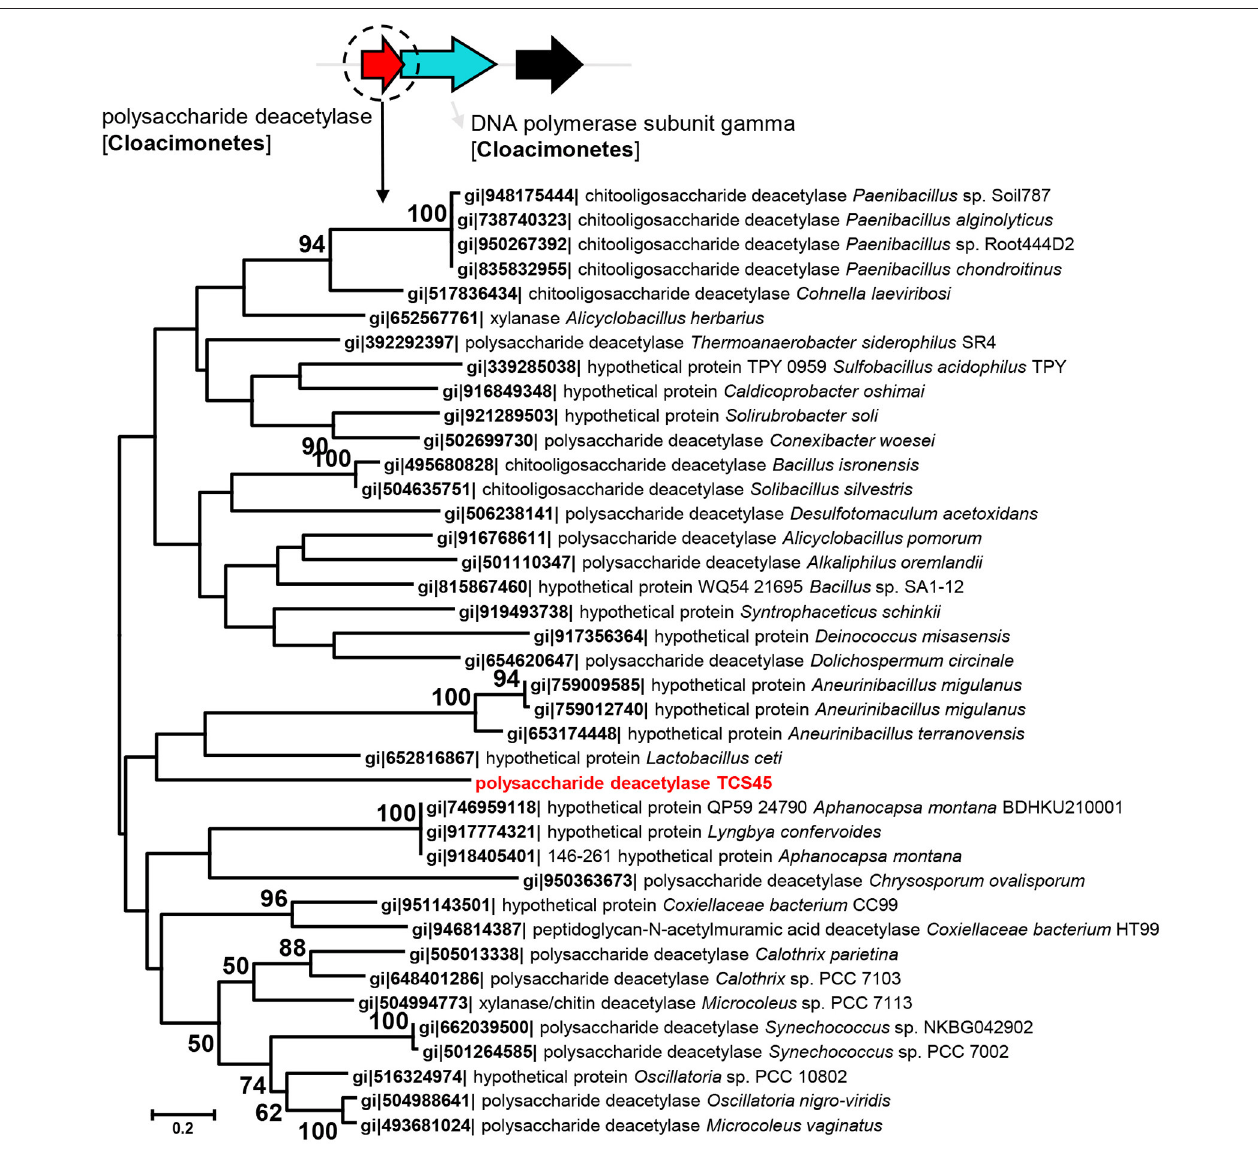
FIGURE 2 | Maximum likelihood phylogenetic tree of the polysaccharide deacetylase in Cloacimonetes bacterium sp. nov. 1. The reference sequences were obtained from NCBI databases. Bootstrap values based on 500 replicates are shown at the nodes. The taxonomic affiliation of the adjacent genes, based on the best hits in the BLASTP search against the NCBInr database are also shown to eliminate the possibility of contig contamination.